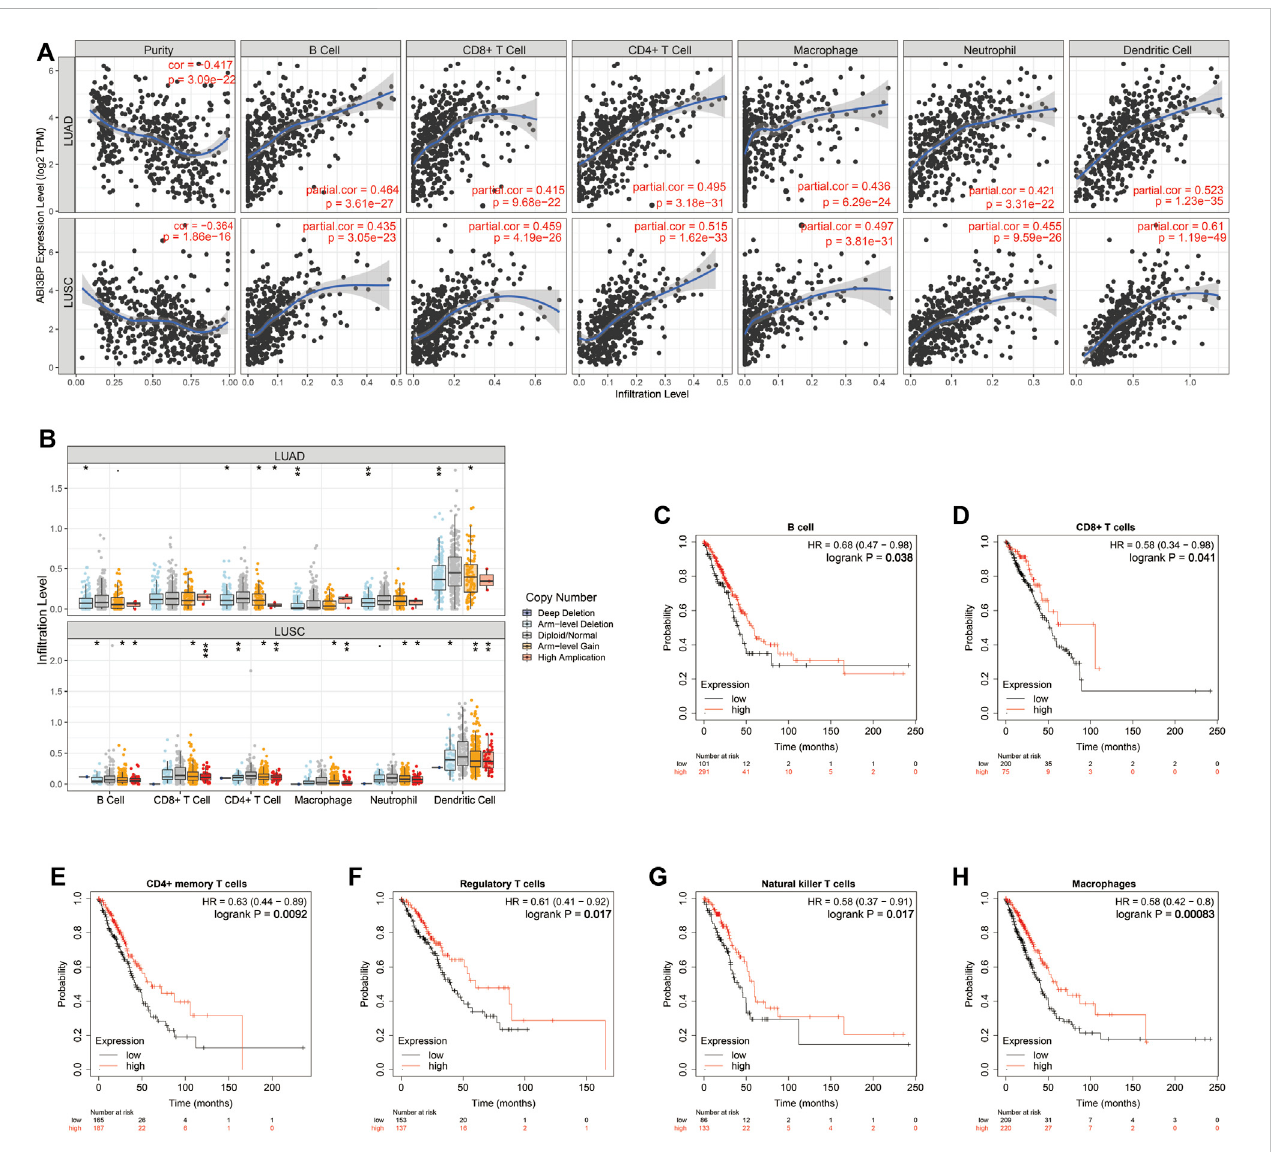
FIGURE 8 Relation of expression of ABI3BP and immune system in fi ltrating cells for lung tumor on the basis of TIMER repository. (A) The TIMER algorithm analyzes the relationship between ABI3BP and immune cell in fi ltration in LUAD and LUSC; (B) ABI3BP CNV in LUAD and LUSC affected the in fi ltration levels of B-cell, CD8 + T-cell, CD4 + T-cell, Macrophages, Neutrophils and Dendritic cells; (C – H) Relationship between expression of ABI3BP and prognosis in patients under immune cell in fi ltration. * p < 0.05; ** p < 0.01; *** p <